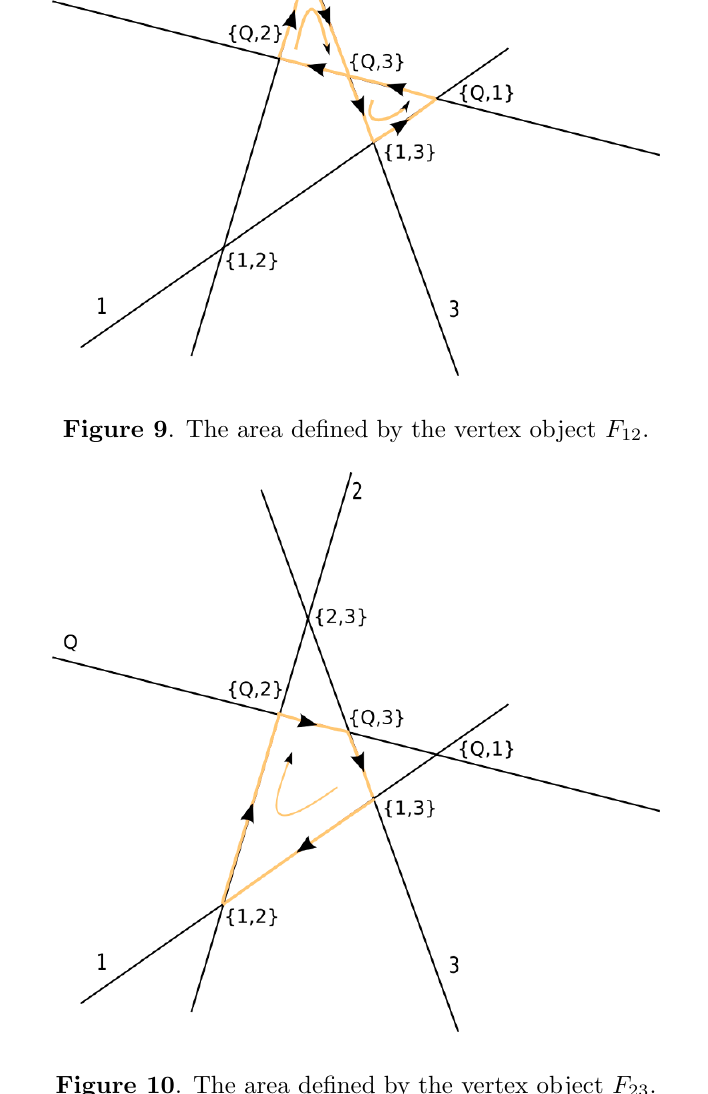
Figure 10 . The area de(cid:12)ned by the vertex object F 23